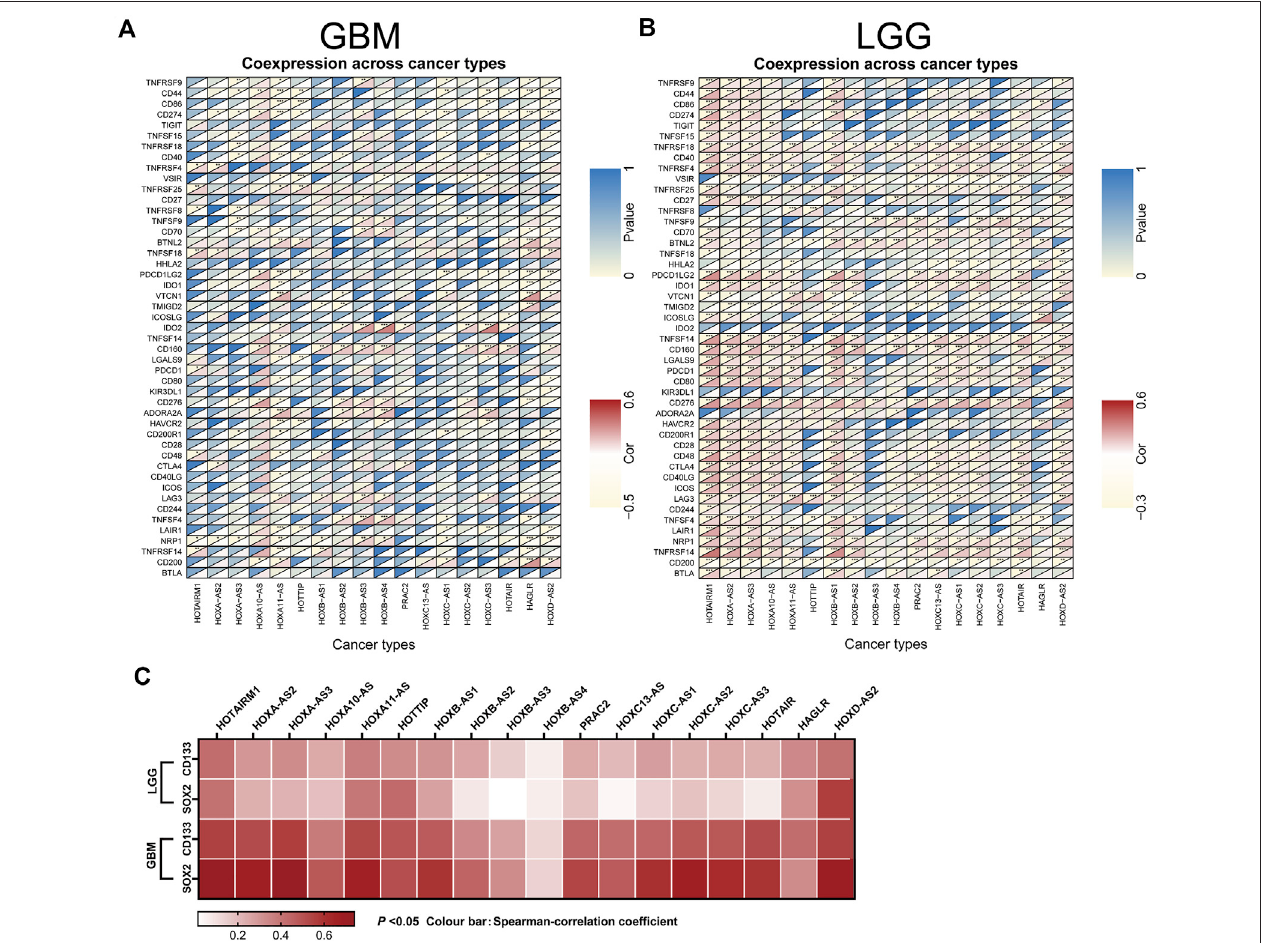
FIGURE 7 | Association of the homeobox antisense transcripts (HOXATs) expression with stem cell and immune checkpoints in GBM and LGG. Co-expression analyses of the HOXATs and the immune checkpoints in the glioblastoma (GBM) (A) and low-grade glioma (LGG) patients (B) . For each pair, the top right triangle represents the p -value, while the bottom left triangle represents the correlation coef fi cient. GEPIA database showing HOXATs expression correlation with stem gene in high-grade glioma tissues compared with that in low-grade glioma tissues (C) . * p < 0.05, ** p < 0.01, *** p < 0.001.